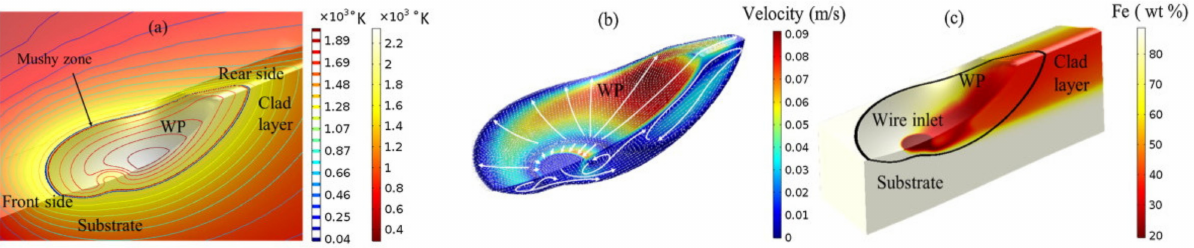
Figure 37. Three-dimensional view of the numerical prediction of the temperature field, velocity field and mass distribution: ( a ) temperature isoterms; ( b ) velocity field; ( c ) mixing phenomena (iron mixture) in the weld pool. Reprinted from Ref.